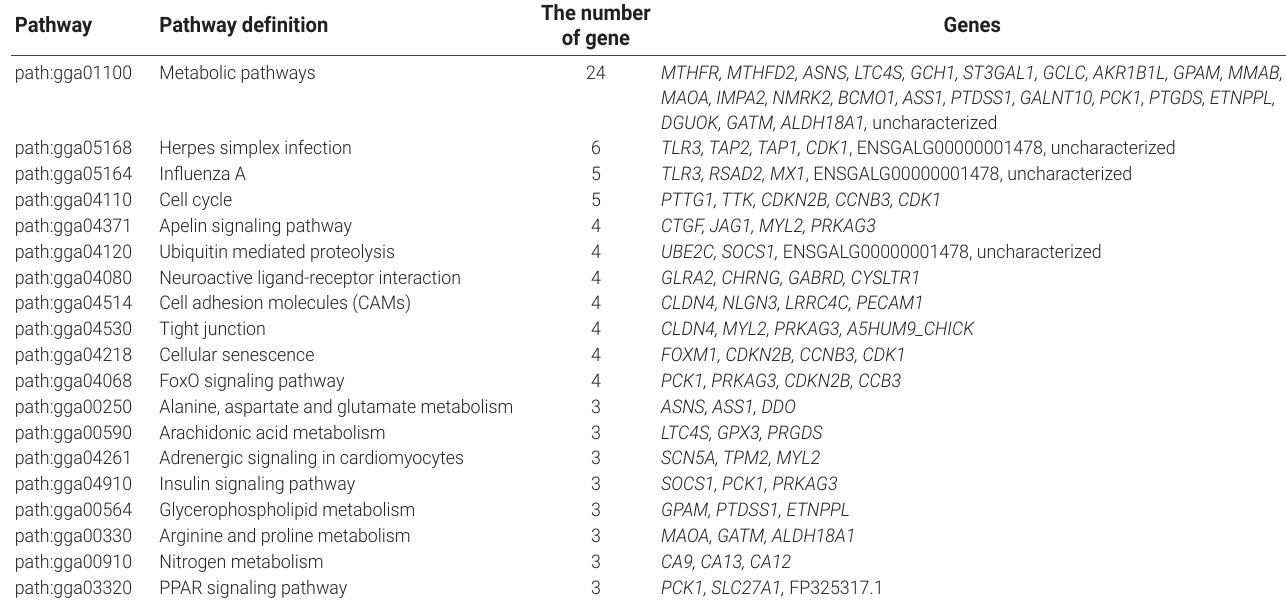
Table 4. Kyoto encyclopedia of genes and genomes pathways enriched with differentially expressed genes responsible for different brown egg- shell color